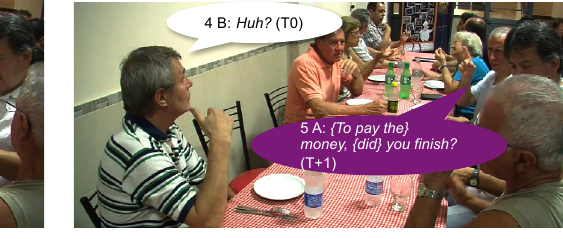
Figure 2. ‘Huh?’ , signer B on the left, initiates repair on A’s previous turn by raising his eyebrows, head up and leaning forward (line